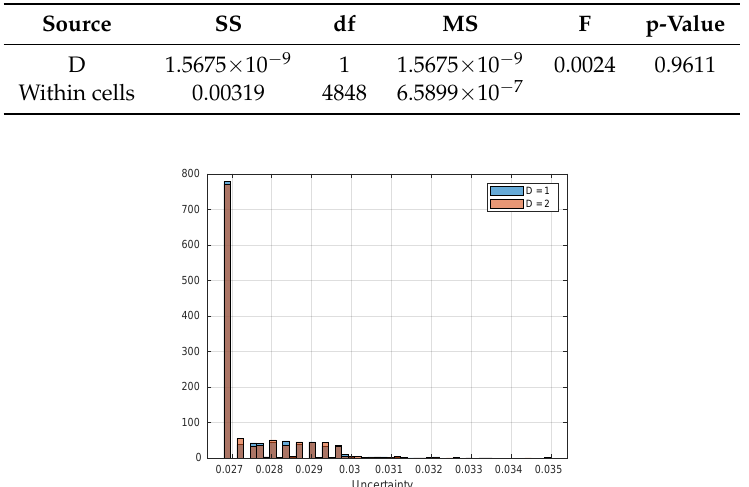
Figure A22. Tree graph for the analysis of the effect of factor D on the expected uncertainty performance. The dashed node and arc correspond to a rejected conclusion due to multimodal population. The arc in blue represents a decision on the value of factor B based on a forced interaction. Table A5. One-way ANOVA table for factor D given B = 2.